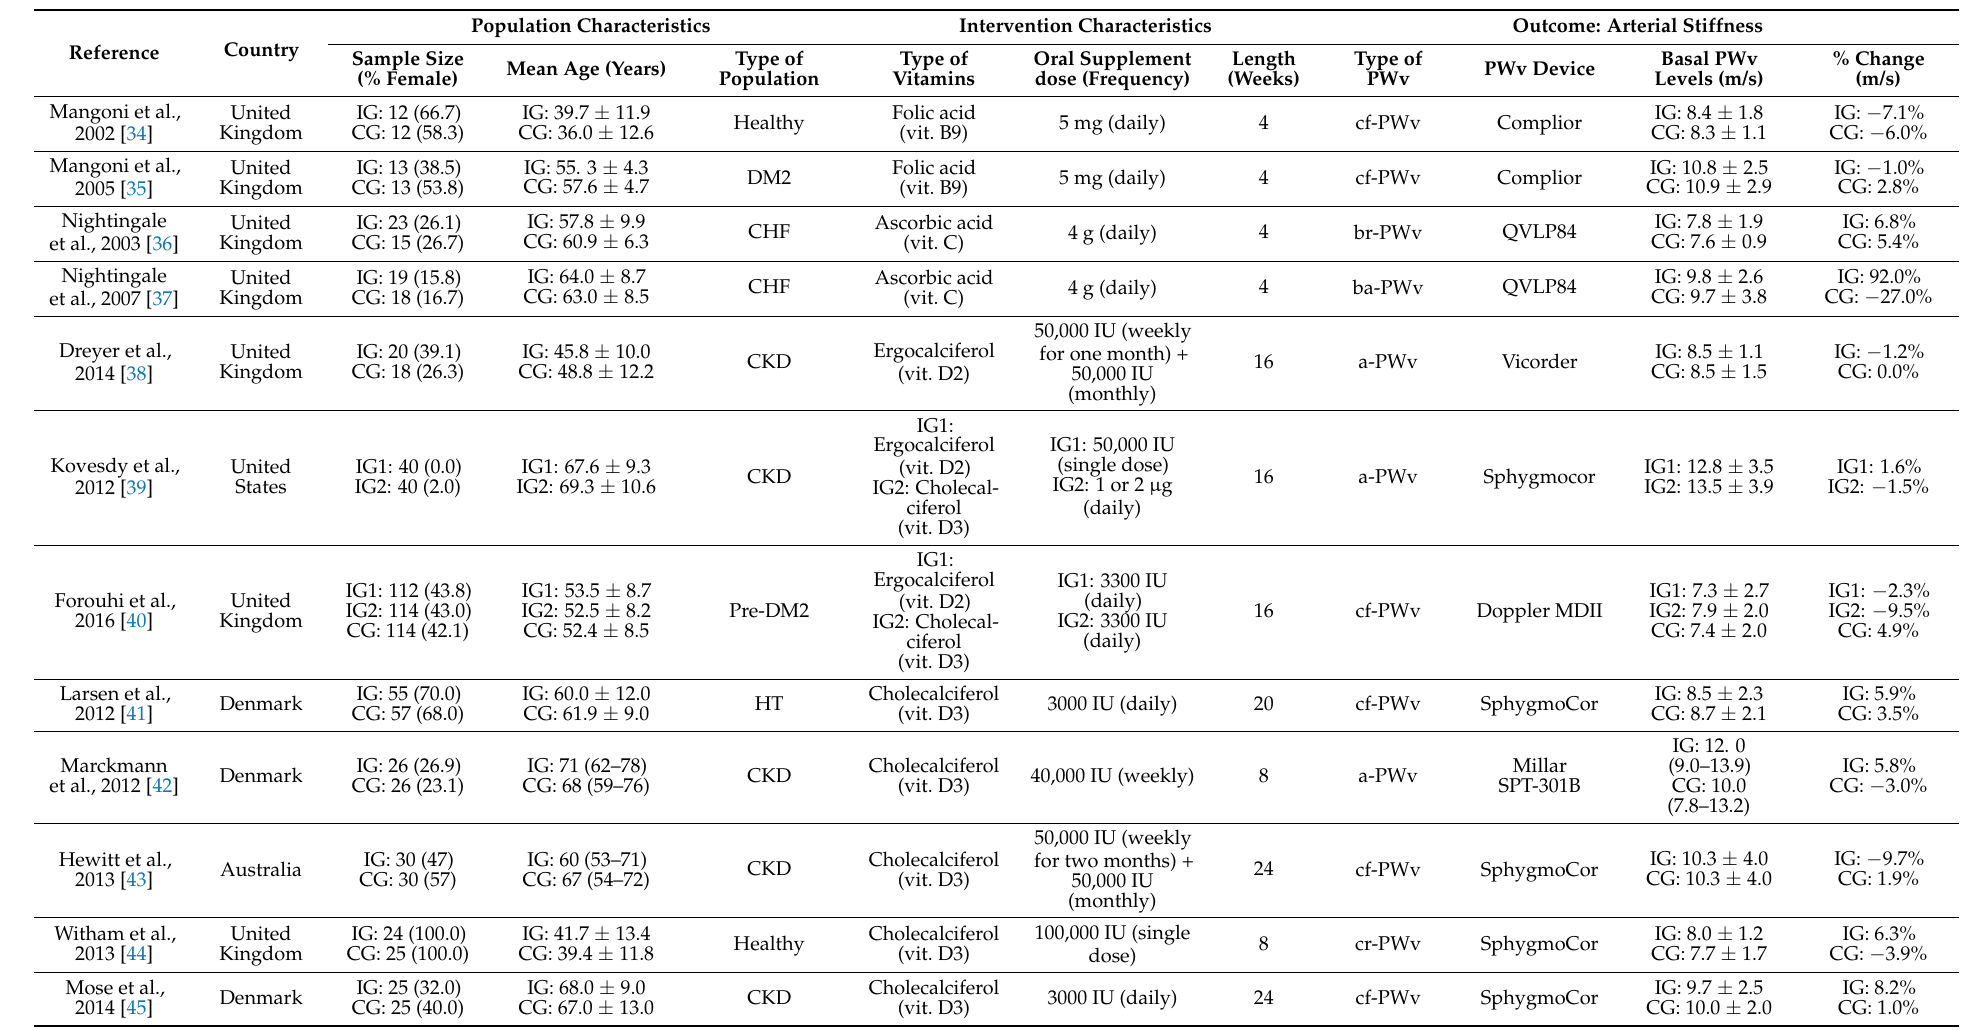
Table 1. Characteristics of the included